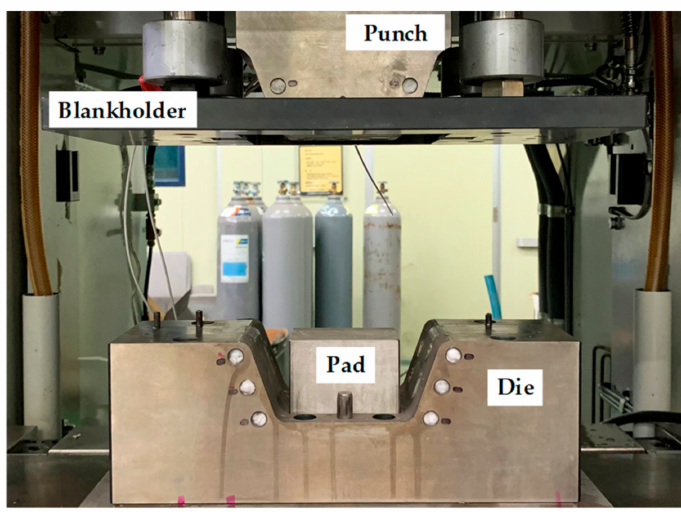
Figure 13. Experimental equipment for manufacturing of Steel/CFRP hybrid